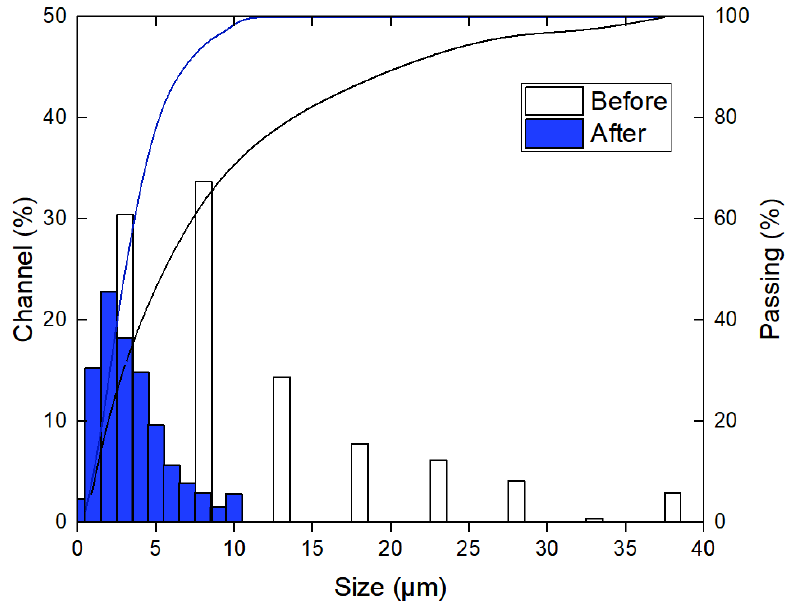
Figure 7. Distribution of tobacco dust size before and after purification.